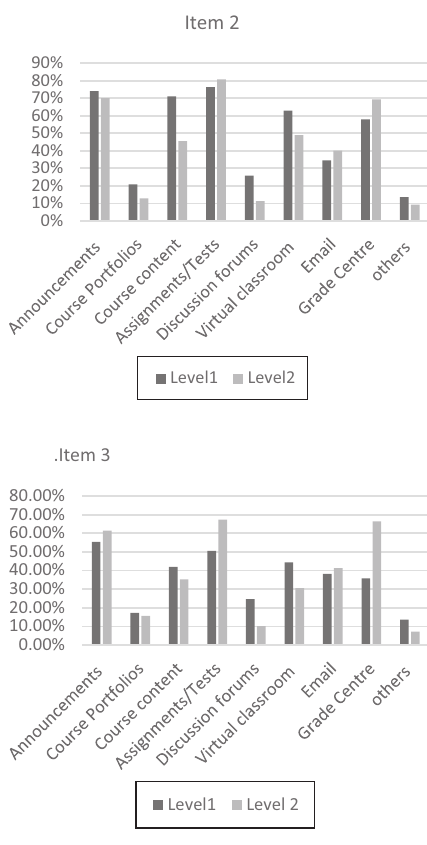
Figure 4. Results of part